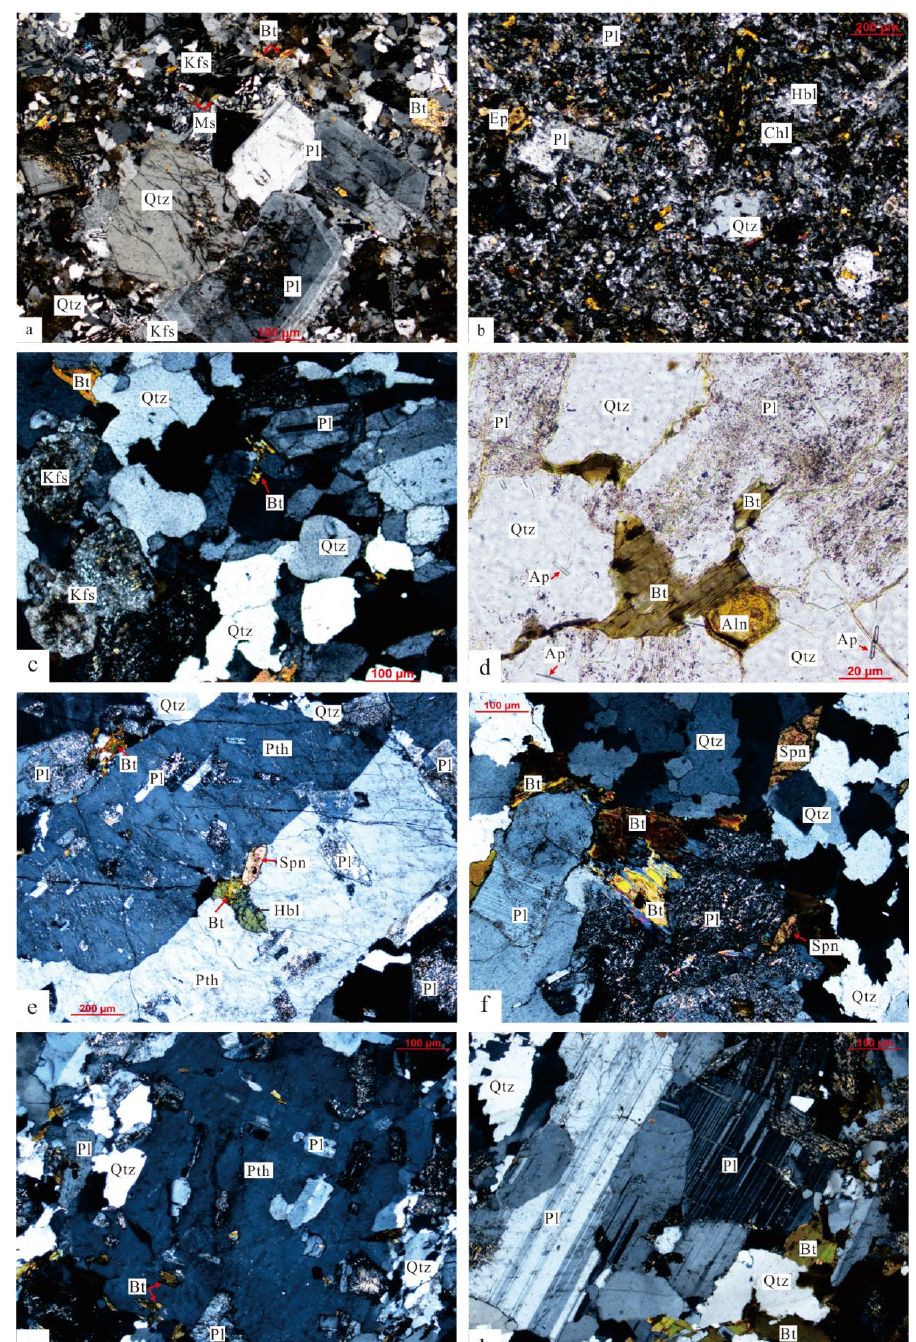
Figure 3. Representative photomicrographs of the Yilashan and Amdo granitoids in the Nagqu area. ( a ) Graphic–myrmekitic textures of granophyres (YLSS–2); ( b ) mineral compositions of quartz diorite–porphyrites (YLSZ–5); ( c ) granite containing K–feldspar, plagioclase, quartz and minor biotite (sample BCD–1); ( d ) biotites occurring as fragments (sample BCD–1); ( e ) Perthite showing Carlsbad twin and containing hornblende and sphene (sample BCN–2); ( f ) plagioclase, quartz and minor biotite and sphene association in granite (sample BCN–1); ( g , h ) mineral assemblage of the sample TL–1. The abbreviations for minerals: Qtz, quartz; Pl, plagioclase; Kfs, K–feldspar; Hbl, hornblende; Chl, Chlorite; Ep, epidote; Pth, perthite; Aln, allanite; Spn, sphene; Bt, biotite; Ap, apatite; Ms,